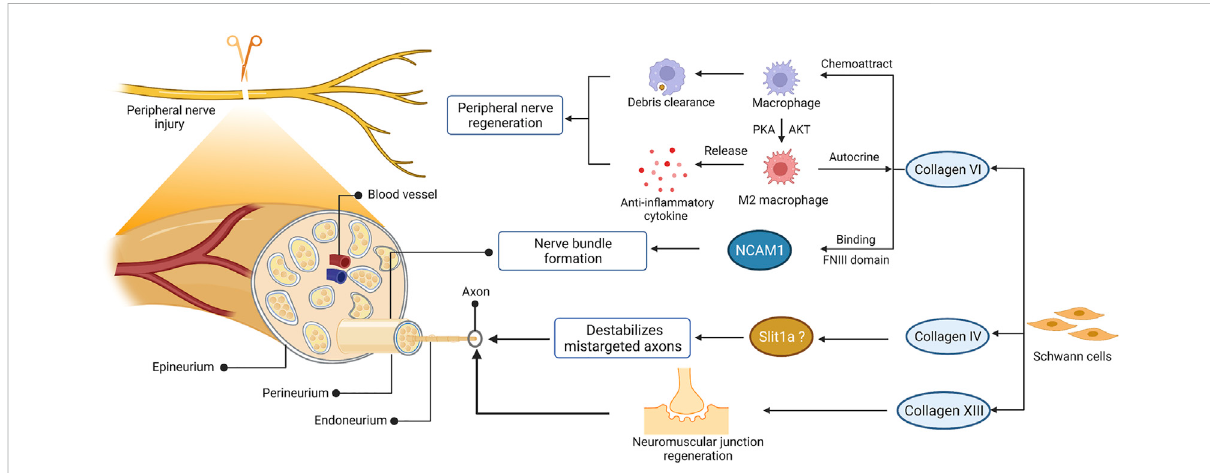
FIGURE 3 The role of collagen in peripheral nerve regeneration. The schematic representations of cross-sectional anatomy of the peripheral nerve and the role of collagen in peripheral nerve regeneration are shown on the left and right, respectively. This fi gure was created with